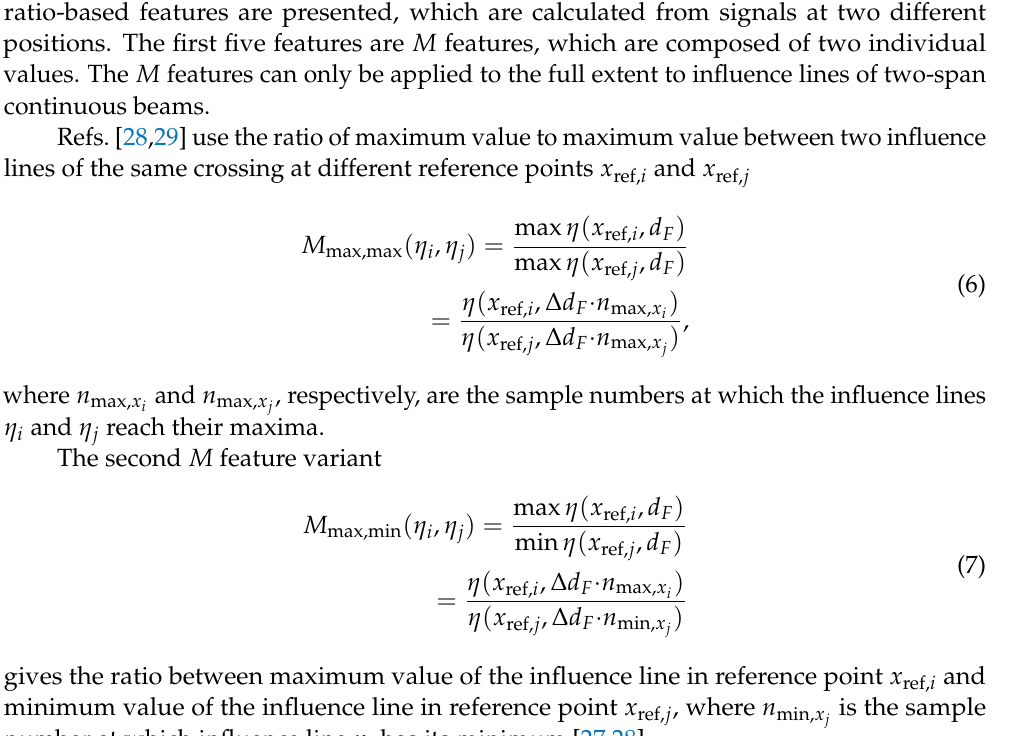
L for the undamaged and damaged 10 L and b 2 = 3 L . 10 10 L . ( b ) Displacement influence line at x ref = 3 L 10 10